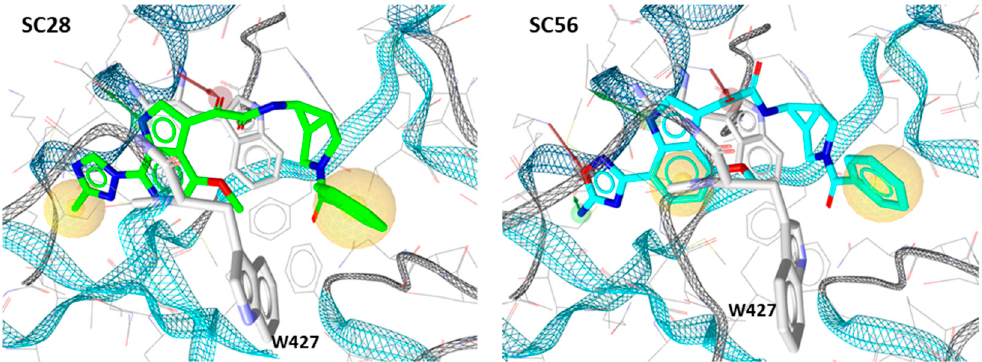
Figure 4. Comparison of the docking models of compounds SC28 (parental; methyltriazole) and SC56 (analogue; amine-oxadiazole) highlighting the difference in the orientation of the W427 indole ring.